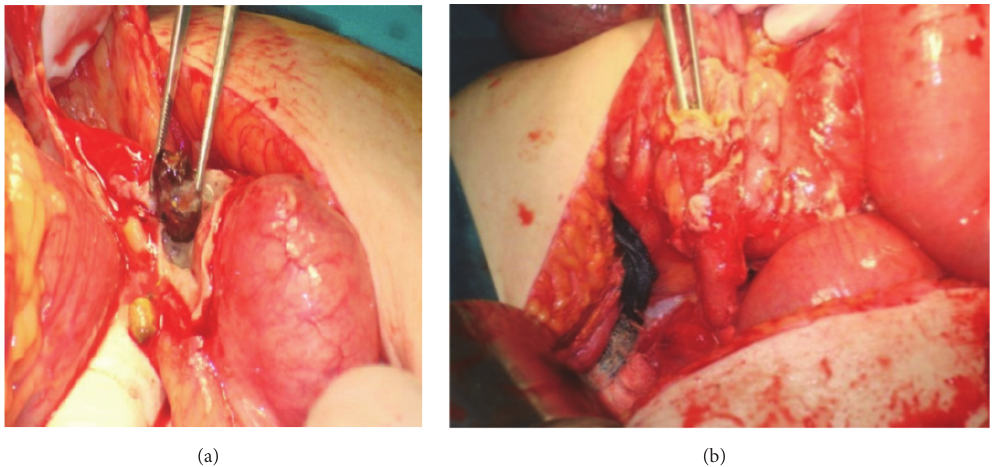
Figure 5: Intraoperative findings. Acute appendicitis with peritonitis. Presence of a